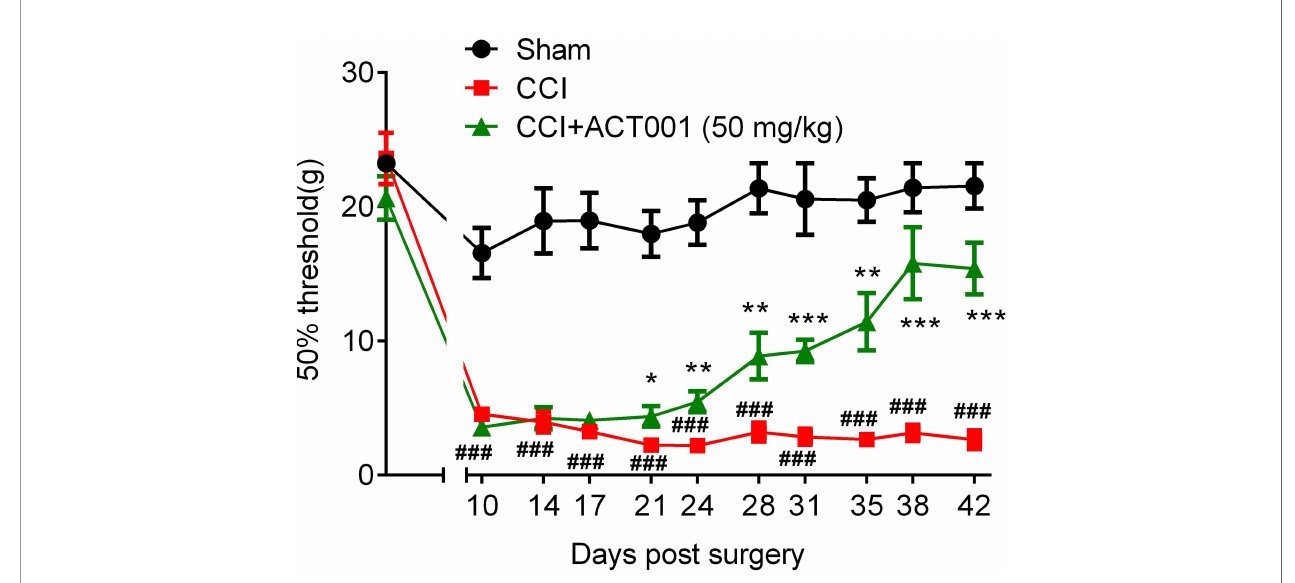
FIGURE 6 | ACT001 attenuates neuropathic pain induced by CCI. All the data represented mean ± SEM. ### P< 0.001 versus the sham group; *P< 0.05, **P< 0.01, ***P<0.001 versus the CCI